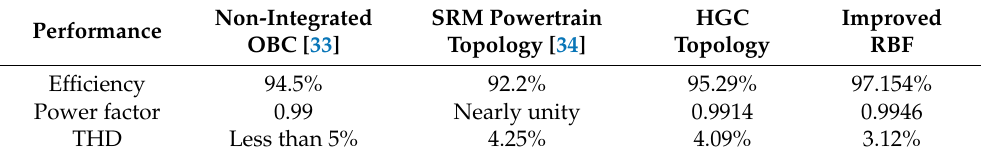
Table 6. Comparison table of existing